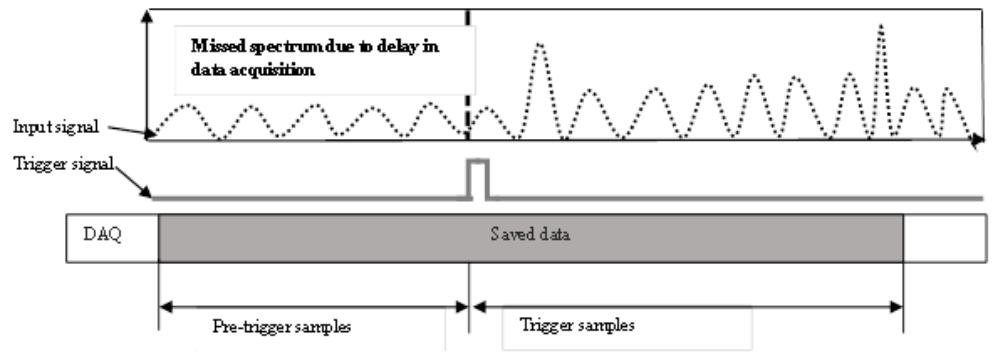
Figure 2. Pre-trigger sampling mechanism of the data acquisition system. The data (input signal, the dotted wavy line) arriving before the trigger event (pre-trigger samples) are saved in the temporary memory of the data acquisition card and then combined with the trigger samples.